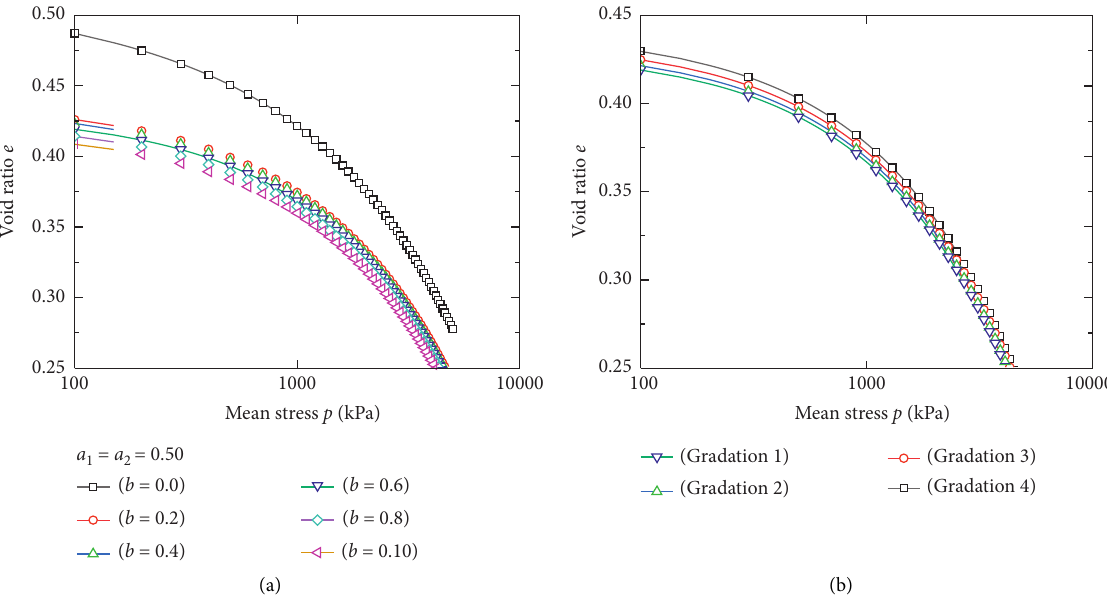
Figure 7: (a) Void ratio at various coefficient of intermediate principal stress. (b) Void ratio at various